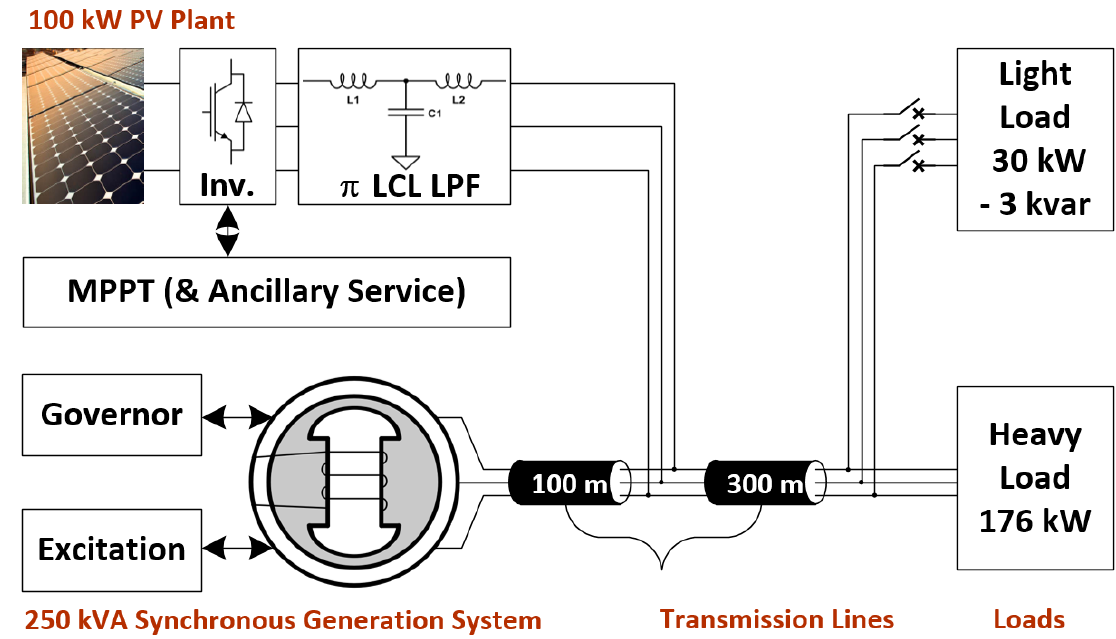
Figure 1. The functional scheme of the micro-grid under